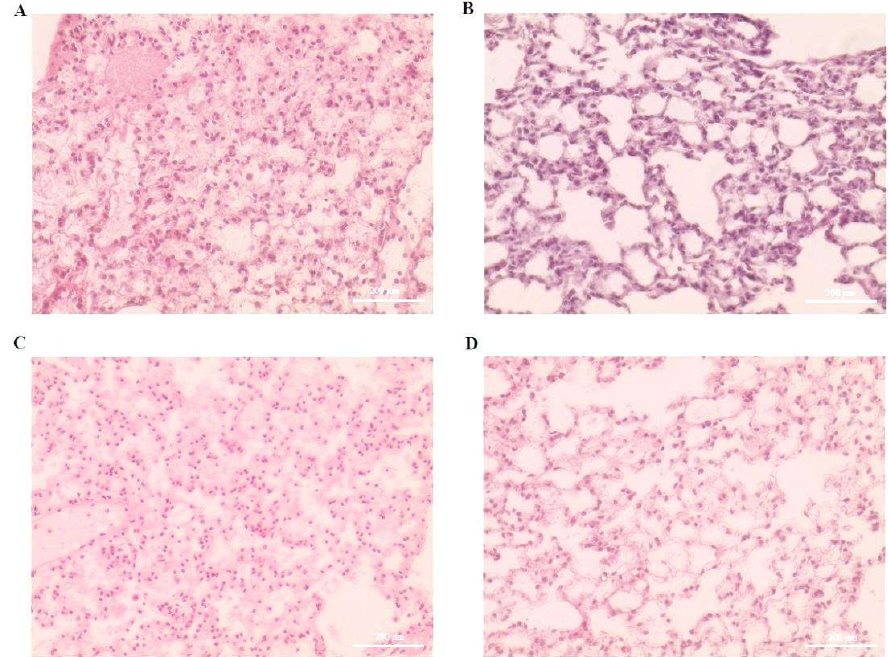
Figure 6. Effect of orientin on LPS-induced inflammatory HSCs. Naïve mouse-derived HSCs were isolated and cultured in an adherent-coated 12-well plate. Cultured cells were stimulated with LPS 10 ng for 2 h and treated with orientin (30 µ M) for 12 h. ( A ) Control group, ( B ) LPS-treated group, ( C ) orientin (30 µ M)-treated group, and ( D ) LPS and orientin (30 µ M)-treated group.